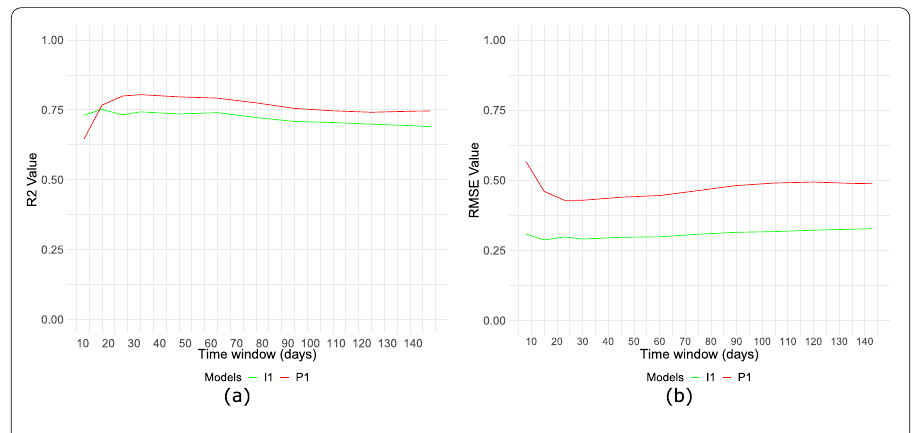
Figure 7 Selected models with different time windows. ( a ) R 2 ( b )